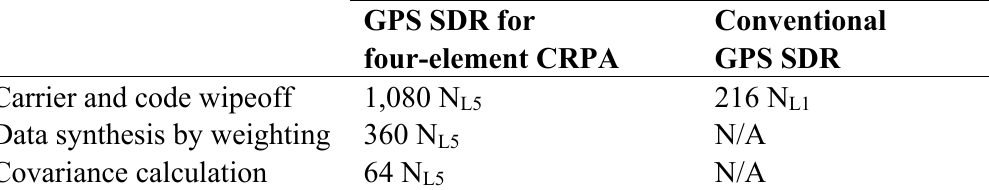
Table 2. Comparison of the required number of multiplications and additions for the GPS SDR for CRPA in this paper and a conventional GPS L1(C/A) SDR. N is the number of inphase or quadrature samples per millisecond (N this